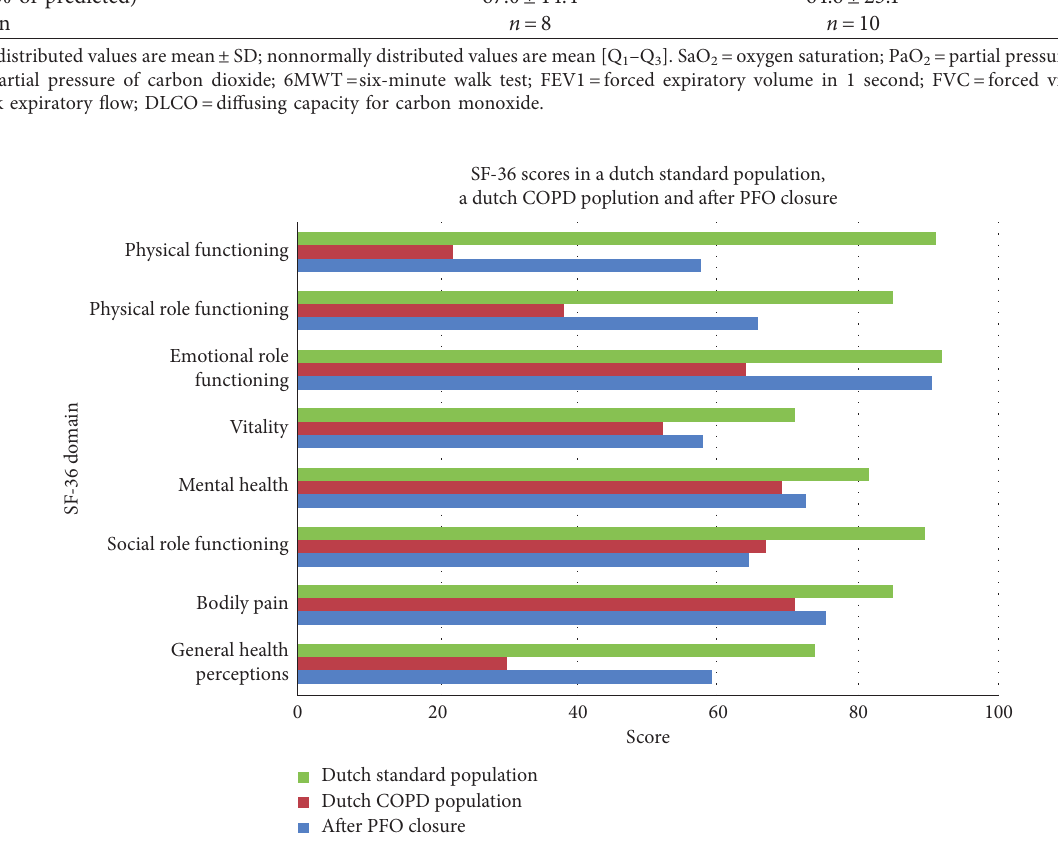
Figure 2: Statistical analysis of SF-36 questionnaire in 8 patients after PFO closure. A slight impairment in quality of life (QoL) is seen in comparison to a standard population. Scores after PFO closure are superior to the scores from patients with advanced